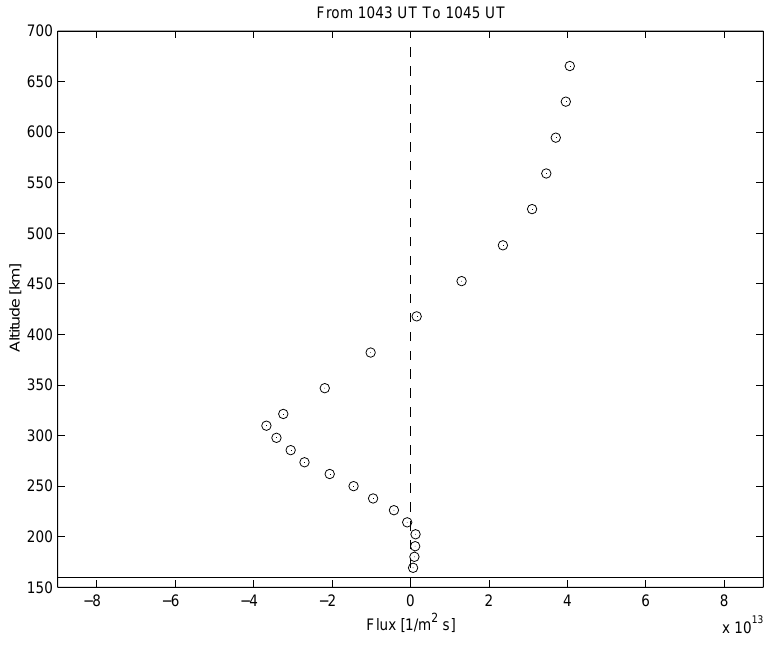
Fig. 3. Field-aligned ion flux calculated from the observed electron density and ion velocity on 08 July 1999, from 10:43 until